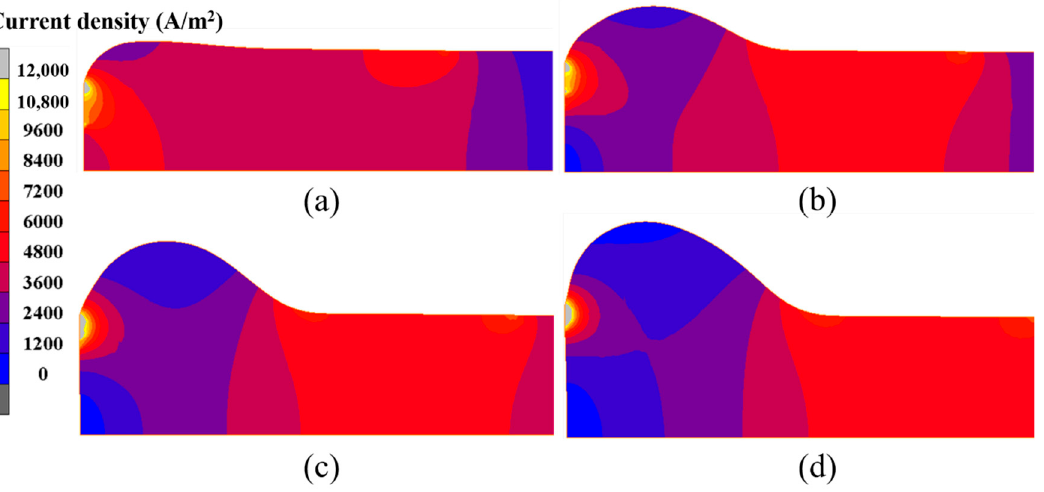
Figure 13. Current density distributions in the billet at different moments of the electric upsetting process: ( a ) 200 s, ( b ) 250 s, ( c ) 300 s and ( d ) 350 s.